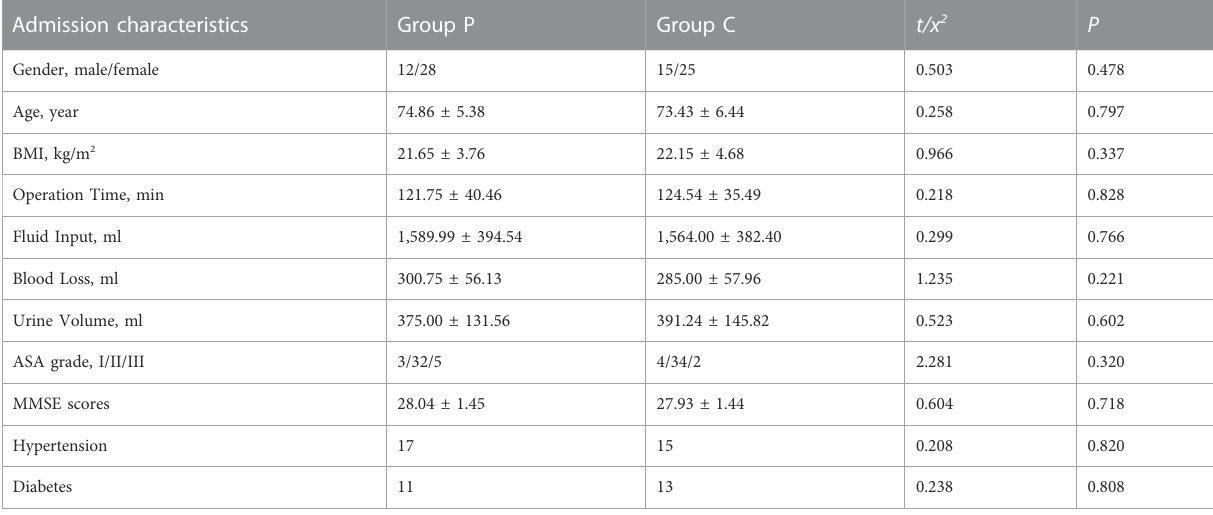
TABLE 1 Comparison of general conditions ( n = 40). Admission characteristics